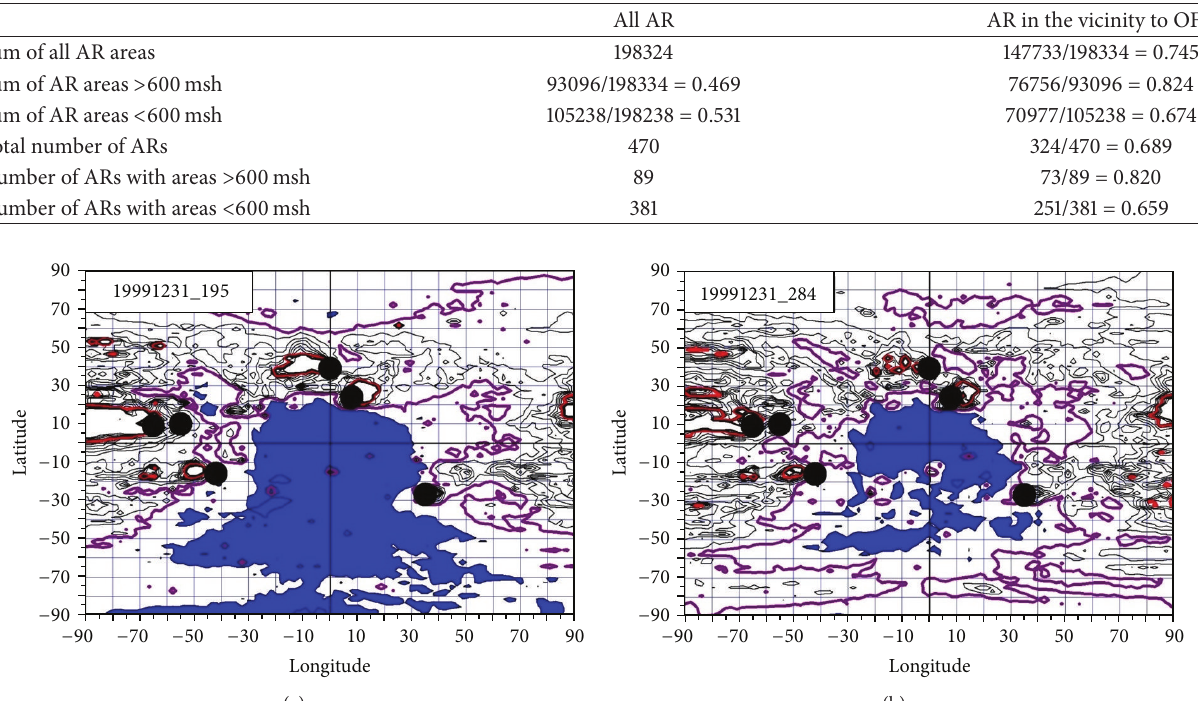
Figure1:HeliographicmapsoftheSunimageinthelines195 A(a)and284 A(b).Thefigureshowscontourlinesofequalbrightness,including the lines of double mean brightness (magenta) and tenfold mean brightness (red). The area shaded blue is the region where the brightness is lower than the average on the given day. The black circles are sunspot